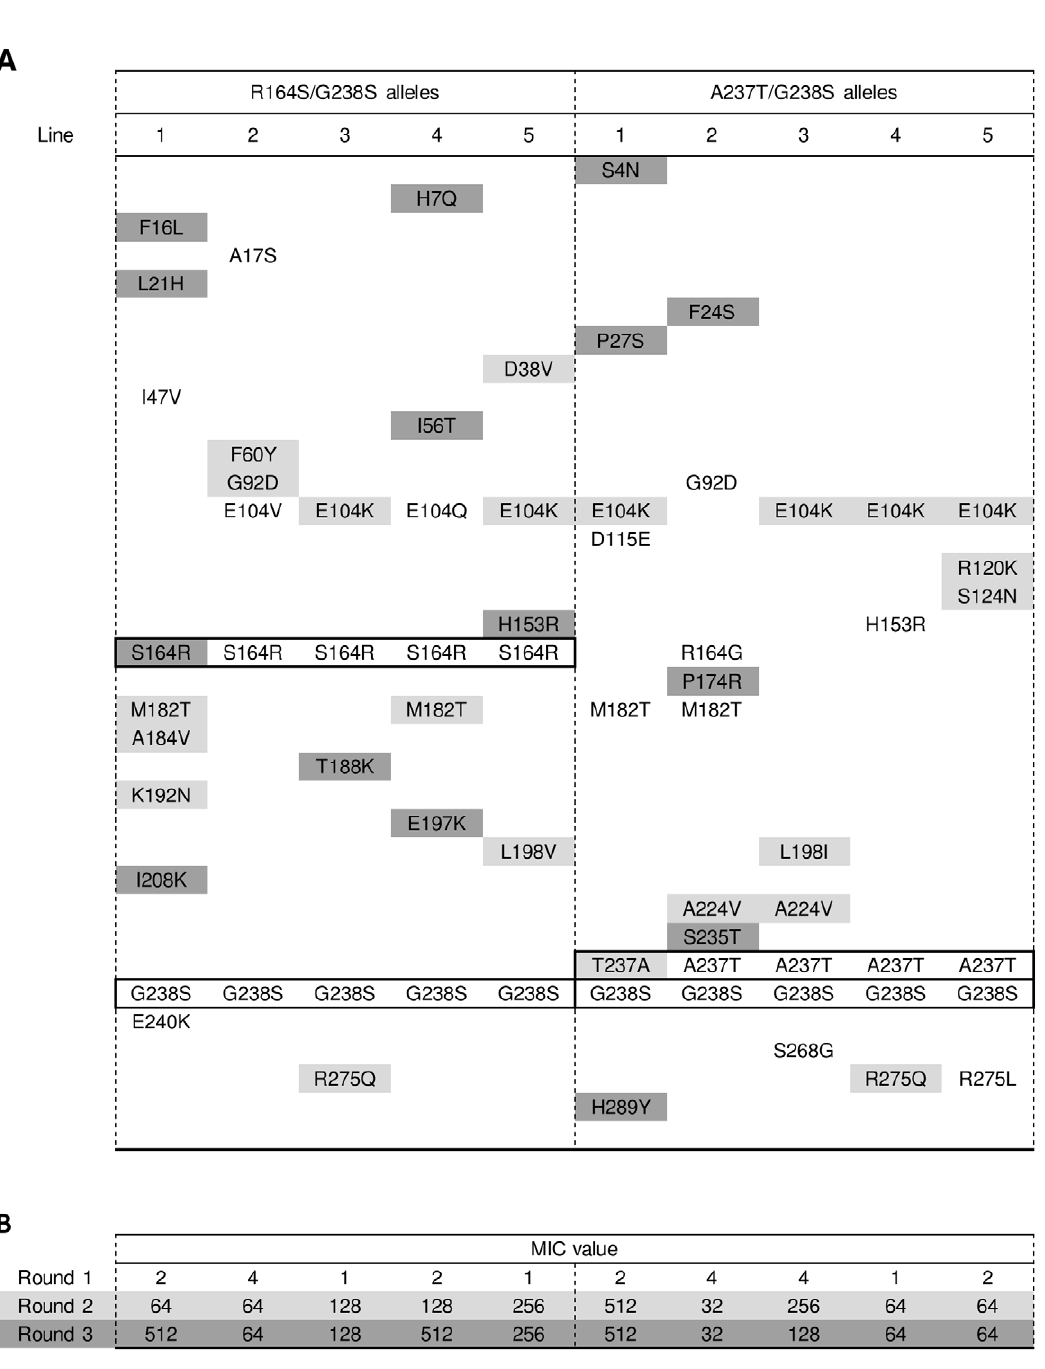
Figure 5. Amino acid substitutions in evolved TEM double-mutants R164S/G238S and A237T/G238S. (A) See legend of Figure 2A for details. The substitutions present in the starting alleles and still present at the end of the experiment have been highlighted by a thick-lined box. Note that all R164S substitutions initially present in the five R164S/G238S lines eventually revert, either after the first (lines 2,3,4 and 5) or the third round of evolution (line 1). Line 1 of the A237T/G238S alleles shows a reversion of A237T after the second round of evolution, while the other four A237T/G238S lines do not show any reversion. (B) See legend of Figure 2B for details.